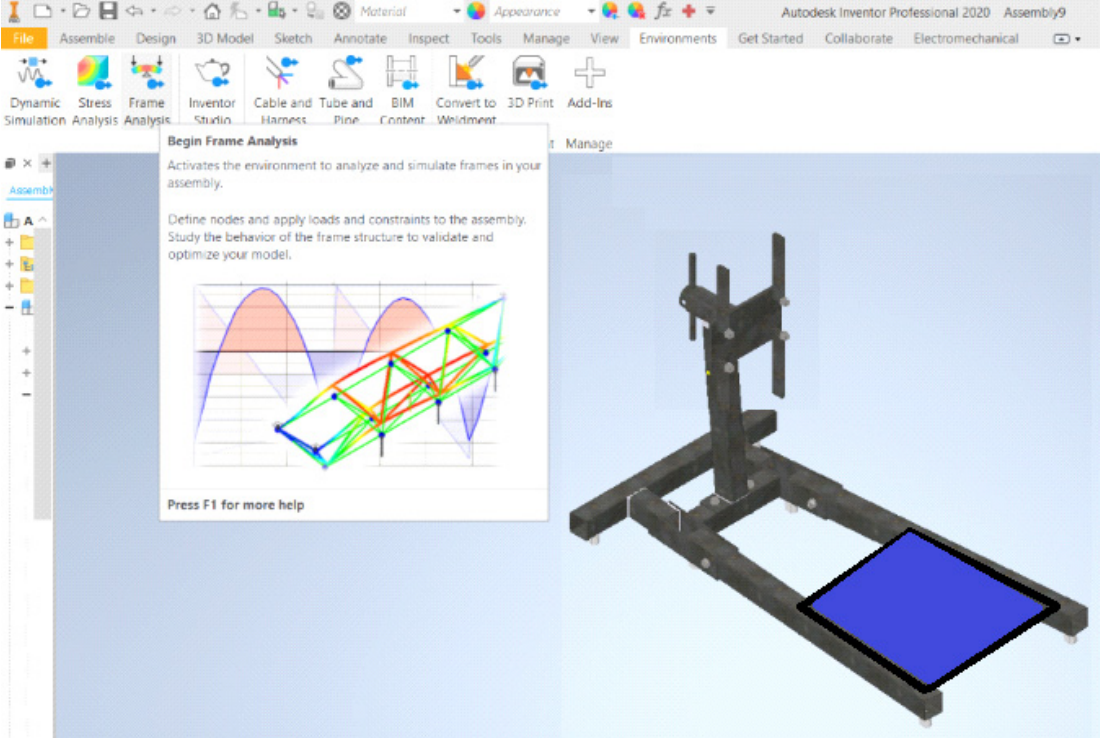
Figure 8. User control interface and the saving tool for coordinates: ( a ) general view; ( b ) reset button.